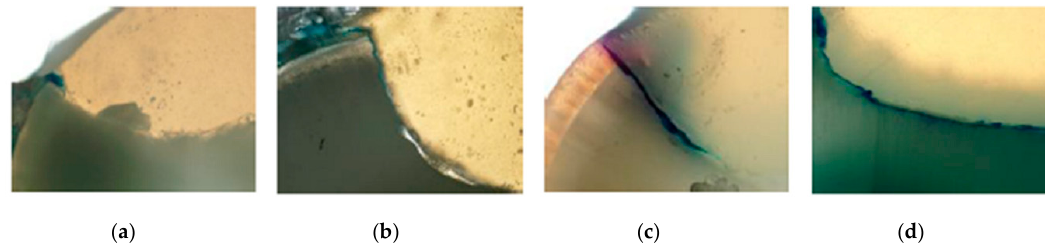
Figure 5. Samples of microleakage in too dry surface cavity conditions: ( a ) Dentsply “Prime and Bond Active”, ( b ) 3M ESPE “Single bond”, ( c ) Coltene “One Coat 7 Universal”, and ( d ) Kuraray “Clearfil Universal Bond Quick”.